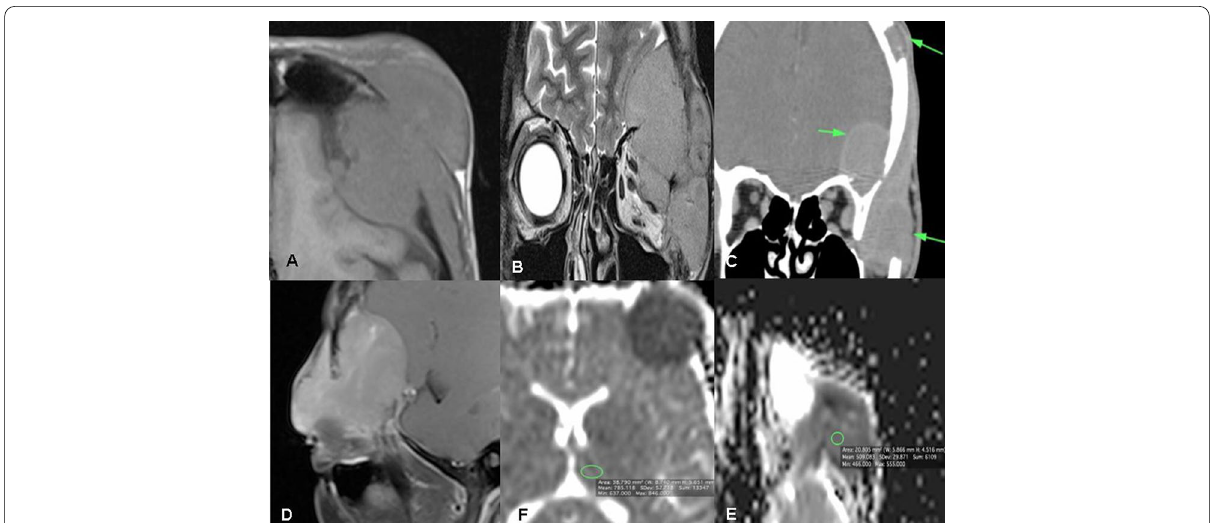
Fig. 10 A 26-year-old female rapidly growing swelling in the lateral aspect of the left orbit, associated with proptosis, headache and dull aching left orbital pain and cervical lymphadenopathy. Axial T1 image A shows hypointense infiltrative mass involving the left lacrimal gland, the left extraconal fat, the lateral bony wall, the left side of skull base, as well as the roof of the left orbit, and has a related left frontal epidural component. Coronal T2 image B shows slightly hyperintense mass displacing the extraconal muscles and the left optic nerve infero-medially. Non-contrast complementary CT study soft tissue window C reveals bone destruction of the left lateral orbital wall, left orbital roof, and lesser wing of sphenoid bone (green arrows). Sagittal T1 post-contrast image D shows mild enhancement of the left orbital mass. Evident diffusion restriction on DWI